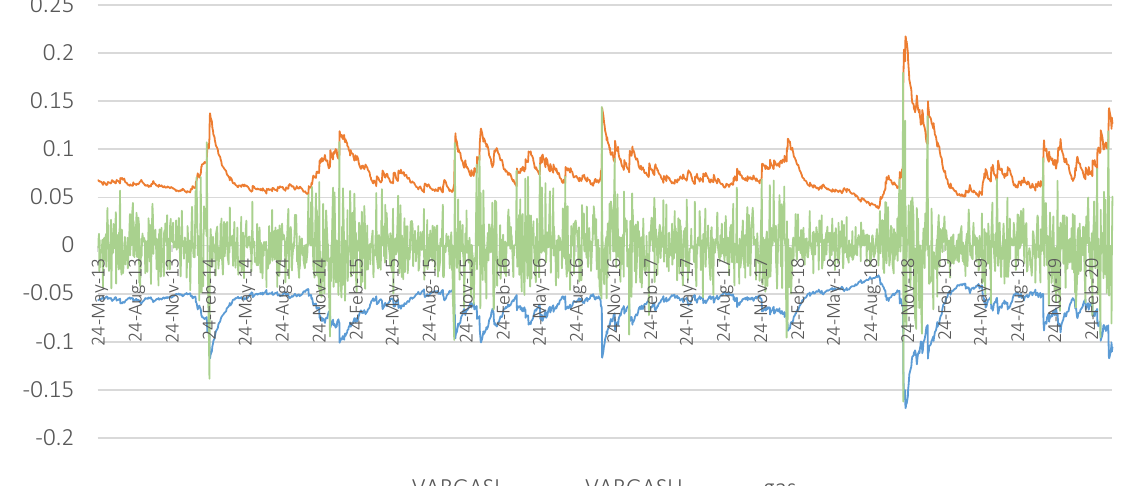
Figure 1. Rolling VaR values and returns of natural gas futures